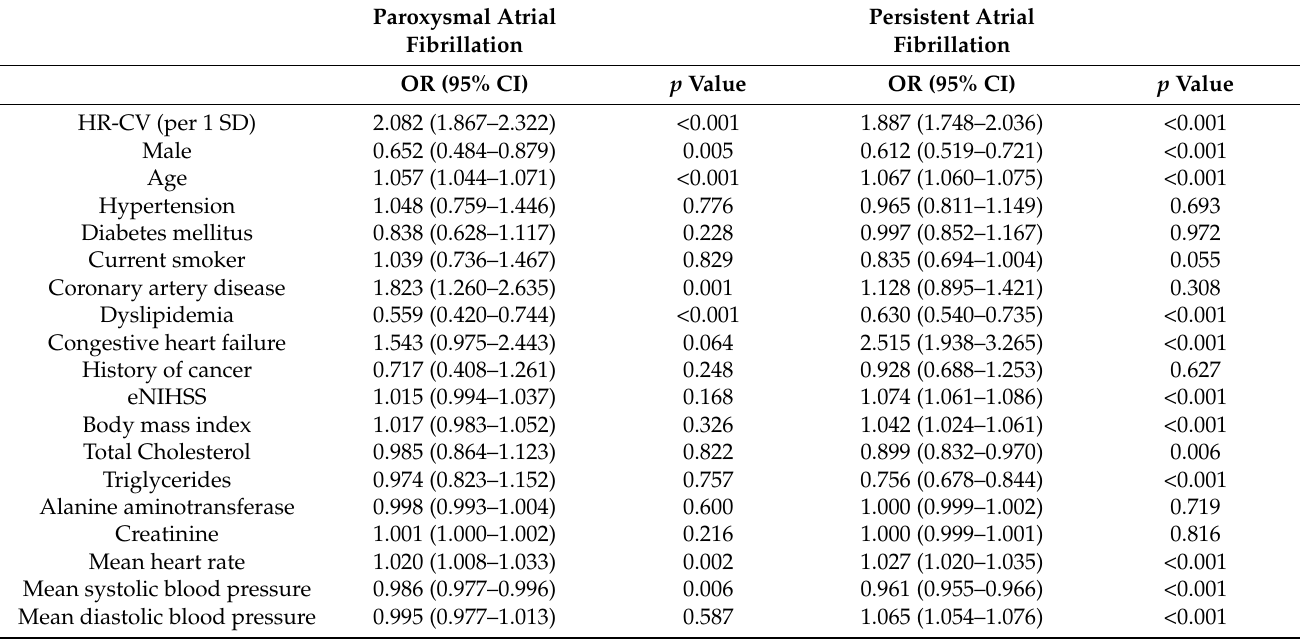
Table 2. Multivariable logistic regression analysis including the HR-CV as a continuous variable for paroxysmal and persistent atrial